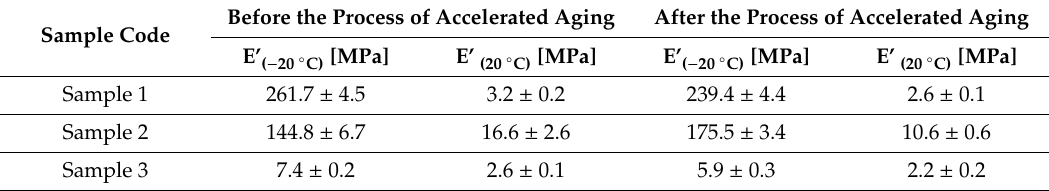
Table 4. Storage modulus (of elasticity) of the material system samples.